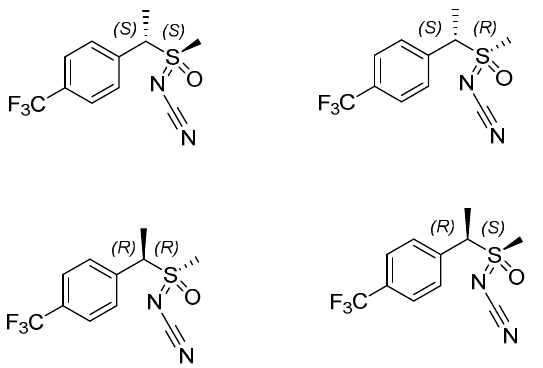
Figure 6. Sulfoxaflor stereoisomers existing as two pairs enantiomers (S,S/R,R on the left and S,R/R,S on the right) and four pairs of diasteroisomers. on the right) and four pairs of